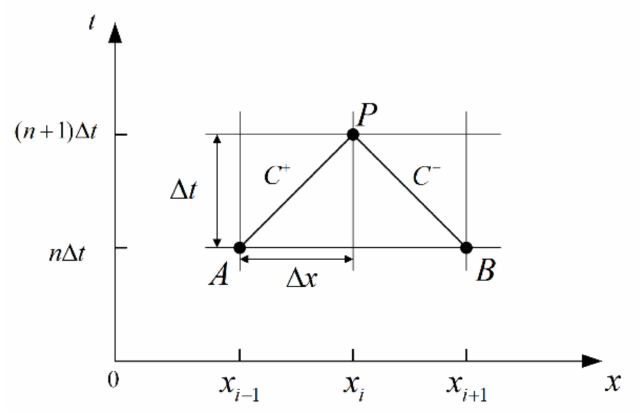
Figure 2. Rectangular grid